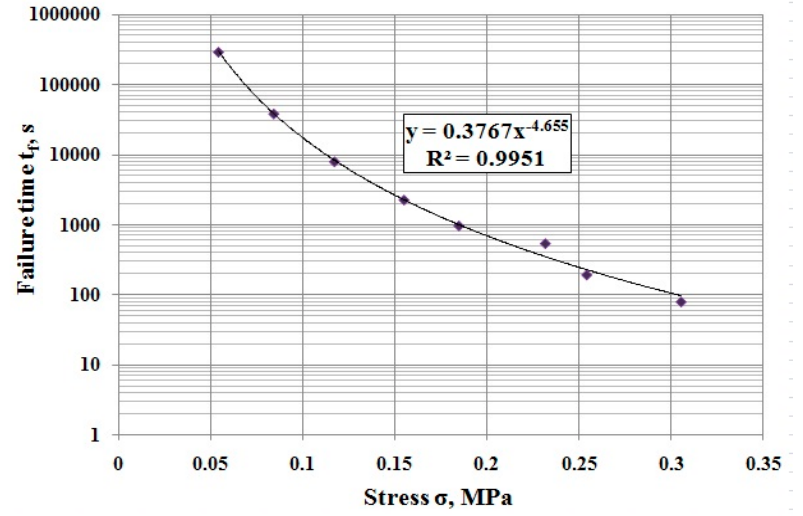
Figure 4. Graph of long-term strength for asphalt concrete at the temperature of 22 ° С .